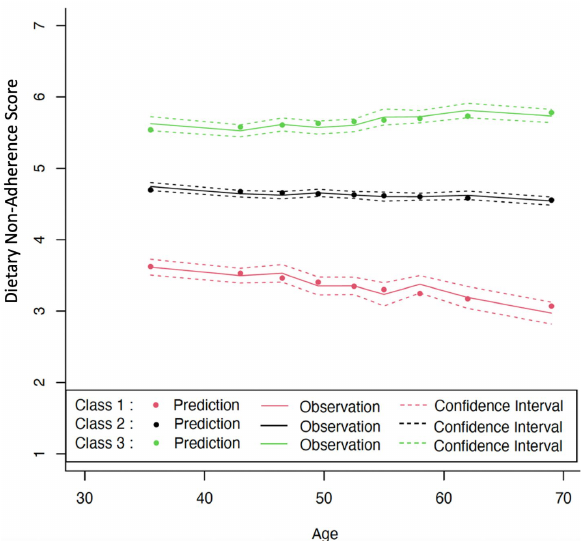
Figure 1. Levels and changes in Dietary Non-Adherence Score (DNAS) over chronological age. Estimated from latent class trajectory modeling. Class 1 = low DNAS, class 2 = medium DNAS, and class 3 = high DNAS . Table 1. Characteristics of participants across classes identified by latent class trajectory modeling (N = 4533) .